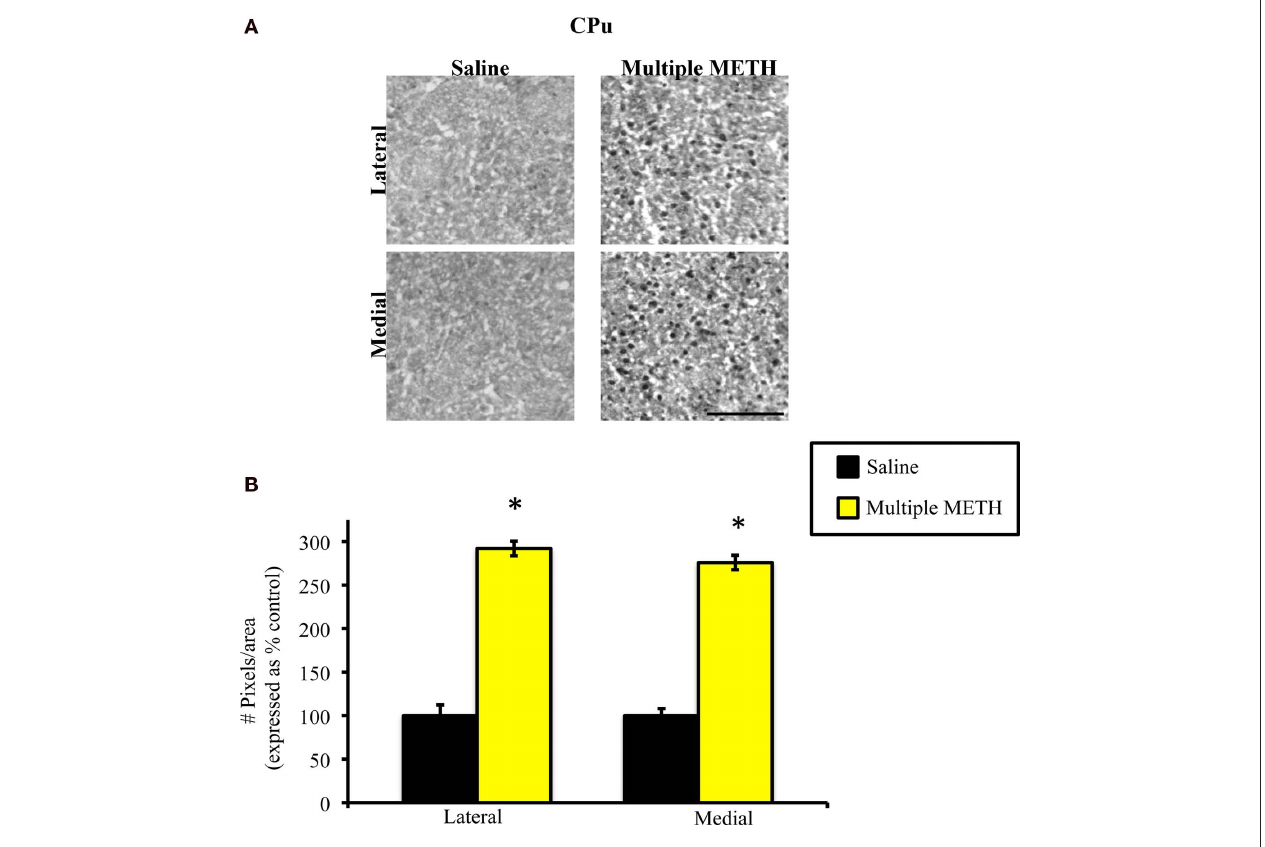
Figure 2 | Photomicrographs of MDA immunoreactivity (MDA-ir) in the lateral and medial CPu (A), 1 week after saline or multiple MeTH treatment (4 × 10 mg/kg, s.c.). Scale bar represents 100 μM. Data are presented as the percentage of MDA-ir particles in saline-treated control